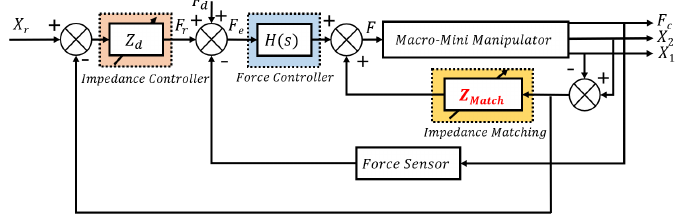
Figure 16. Block diagram of impedance control with impedance